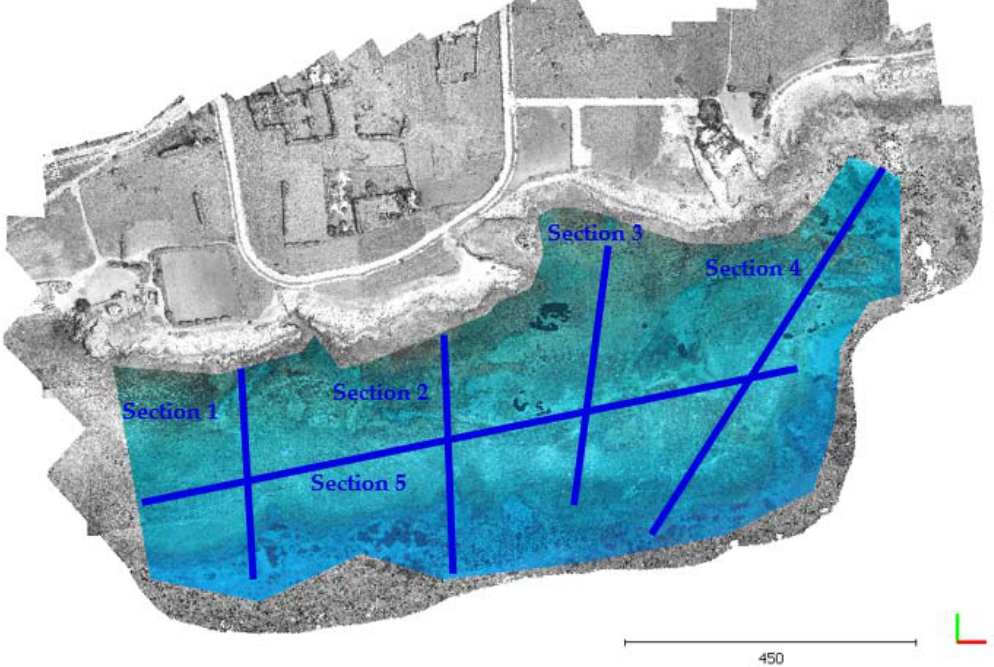
Figure 19. Agia Napa test site and the cross ‐ section paths.